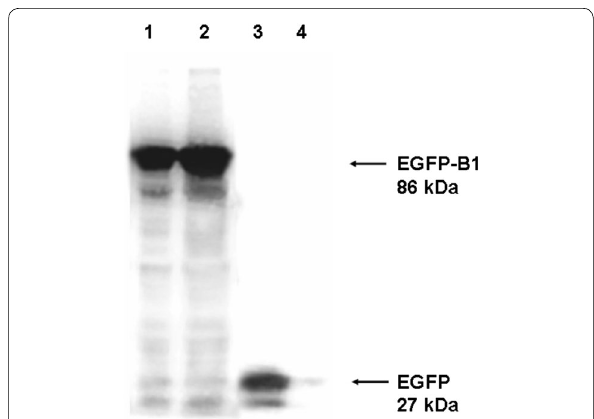
Fig. 4 Western blotting analyses of the total cell protein of BL21AI‑GBS equal amounts of the total cell protein of BL21AI‑GBS, BL21AI‑GB or cells harboring pL‑EGFP and plasmid‑free E. coli BL21AI TM were separated by SDS‑PAGE and detected with anti‑GFP antibody and anti‑mouse IgG antibody. Lane 1 to lane 4: samples of BL21AI‑GBS, BL21AI‑GB or cells harboring pL‑EGFP and plasmid‑free E. coli BL21AI TM , respectively